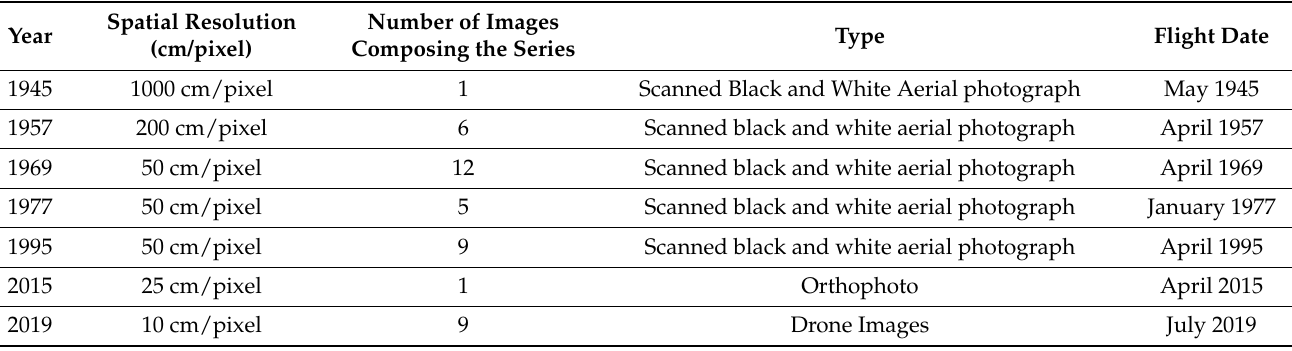
Table 1. Aerial images used in this